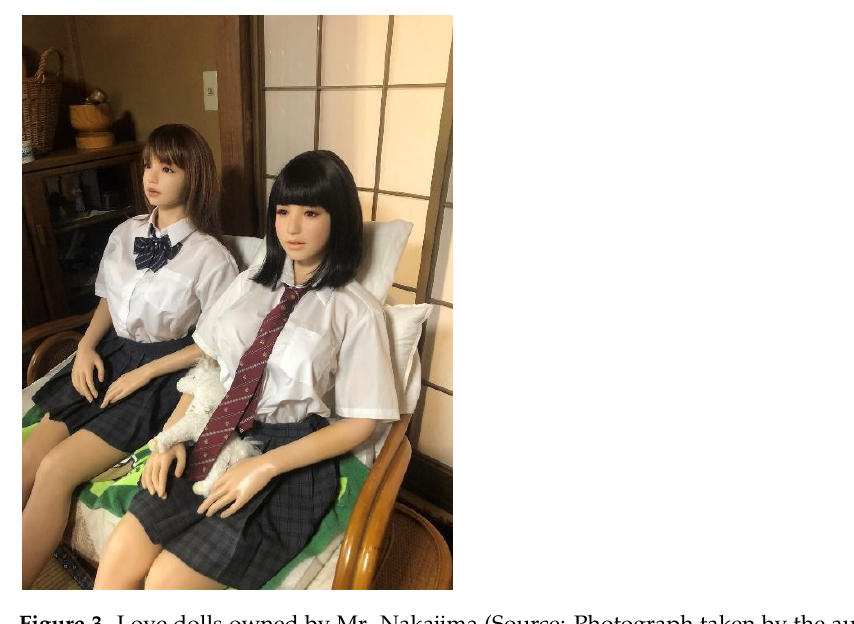
Figure 4. Responses on the owners’ feelings about Robohon (Source: Prepared by the authors).